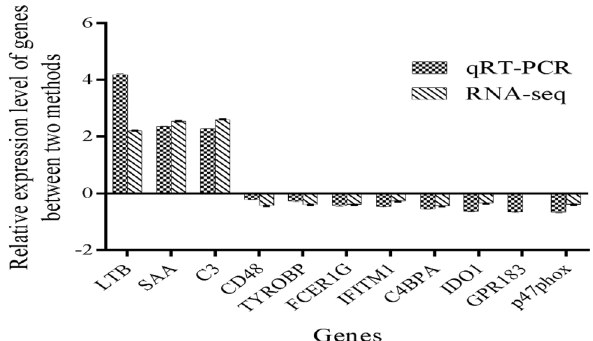
Figure 11. Validation of gene expression data using